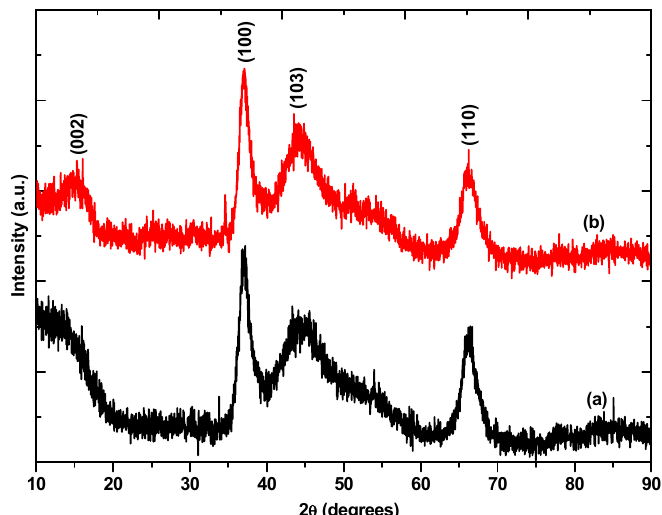
Figure 1. Powder X-ray diffraction patterns of ( a ) MoSe 2 nanosheets ( b ) MoSe 2 nanoflowers.